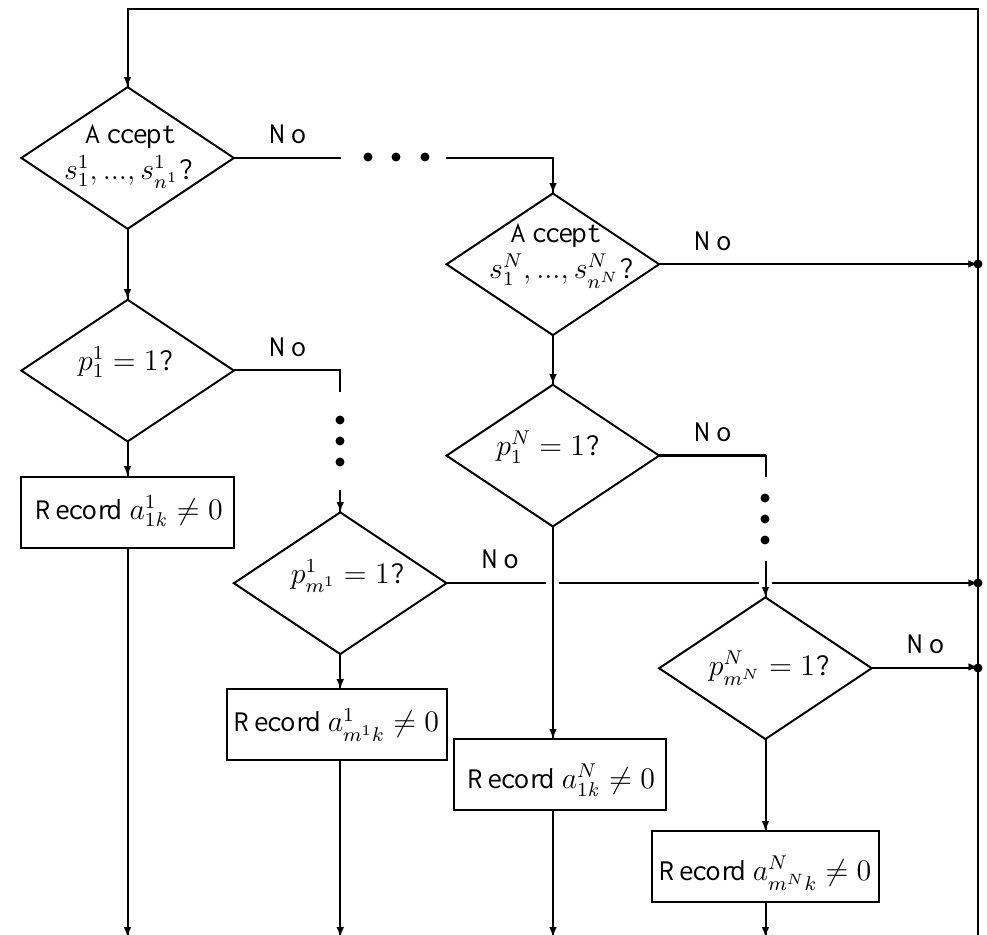
Organization of “if–then–else” blocks in the control structure of a minimal